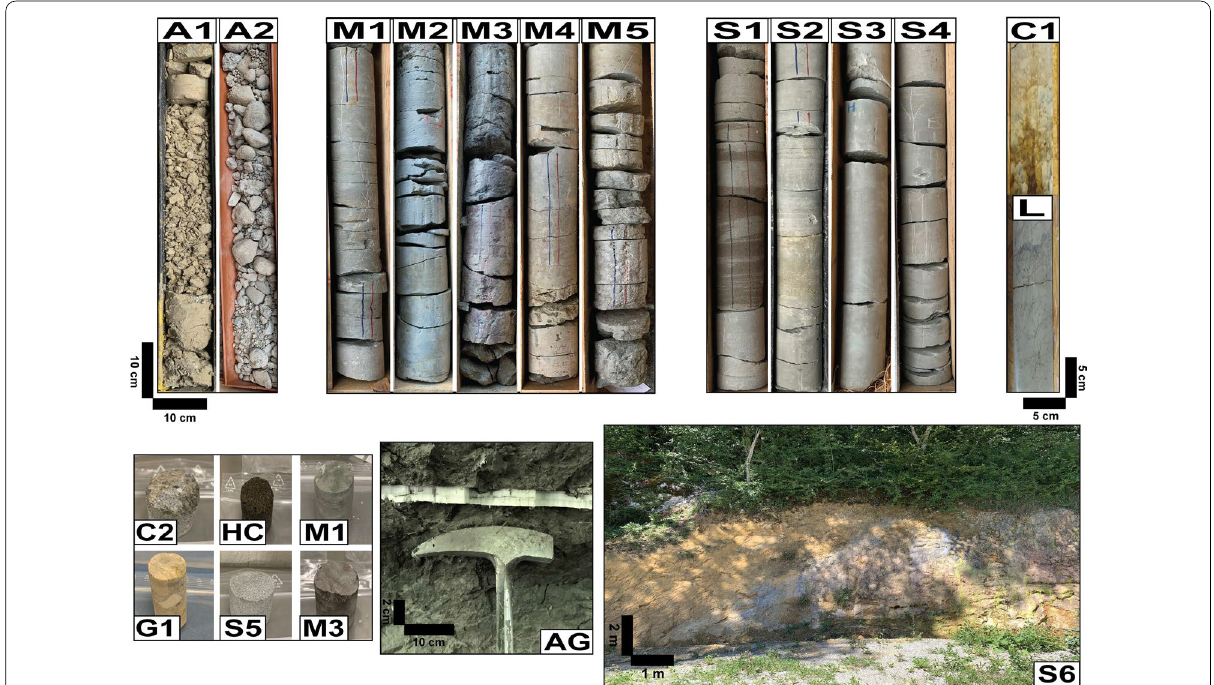
Fig. 4 Lithotypes analysed and encountered along the FCC’s current tunnel alignment from small-scale drilled plugs to rock cores and large-scale outcrops. A1–A2 Quaternary glaciogenic deposits, M1–M5 different marls as part of the Molasse Rouge formation, S1–S5 different sandstones as part of the Molasse Rouge formation, S6 sandstone as part of the Siderolithic formation, often referred to as Gompholite , HC hydrocarbon-bearing sandstone in the Molasse Rouge formation, C1-C2 different conglomerates as part of the Molasse Rouge formation, L freshwater limestone as part of the Molasse Rouge formation, G1 sandstone as part of the Siderolithic Formation, AG gypsum layer in the Molasse Rouge formation. See text for detailed